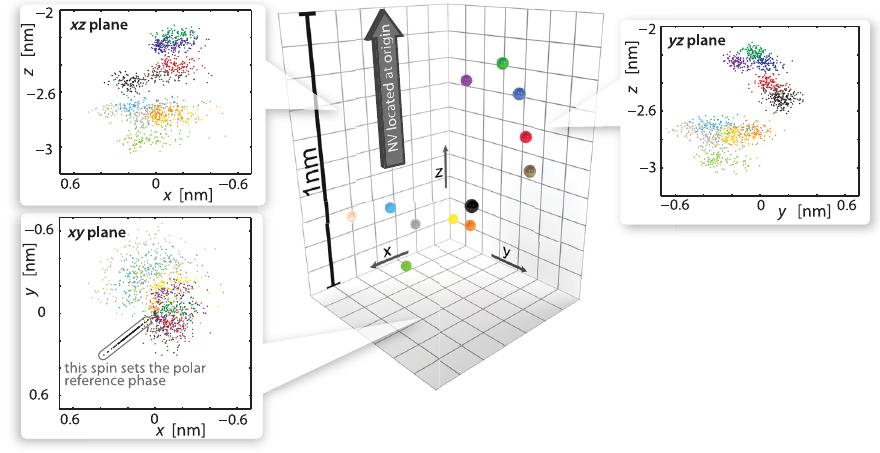
FIG. 5. Accuracy of the position assignment obtained from our proposed sensing method for the 13 C nuclear spins in the 183 and 185 residues of CXCR4 [29]. The spatial reconstruction uncertainty for the positions of 13 C nuclear spins [34] is shown as scatter plots in the three planes, where the color defines the nuclear spin it refers to. We assumed a constant error Δ A Δ D ¼ 0 . 5 D ij ij